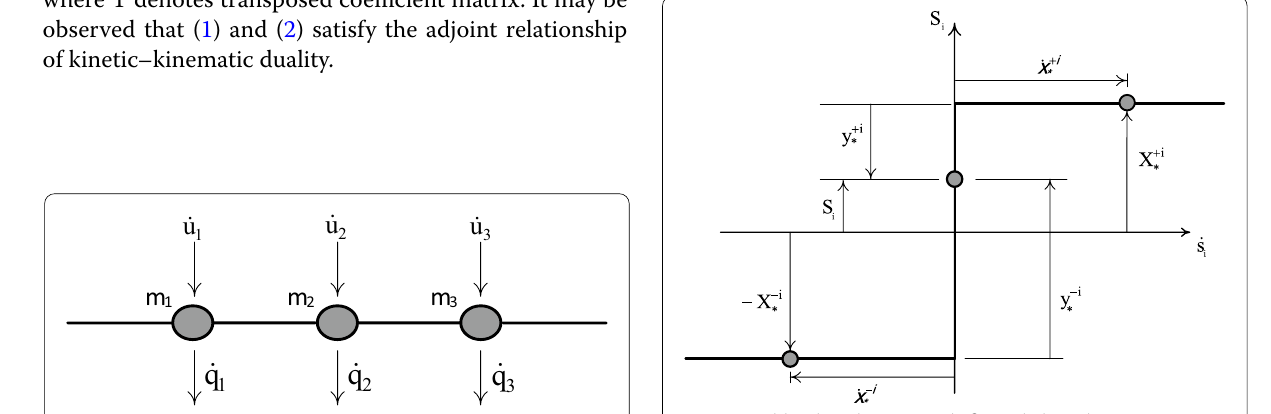
Fig. 2 Centroidal velocities in a lumped mass system.